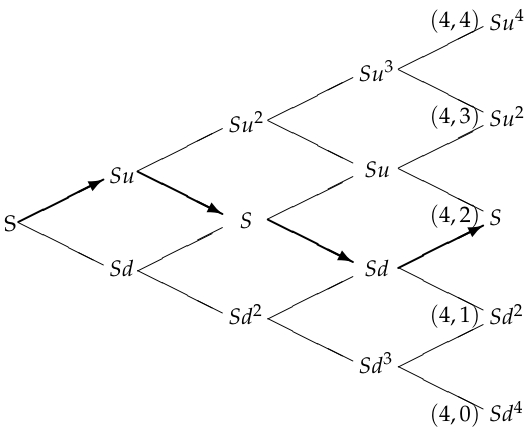
Figure 4. Unconsidered trajectory for node ( 4,2 ) in regime